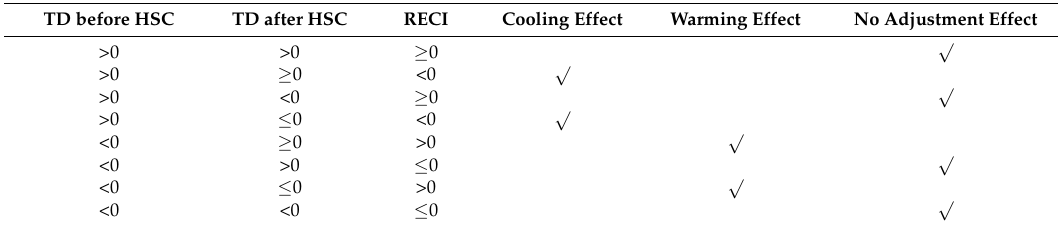
Table 2. Reservoir effects on temperature regulation. Visa sign ( temperature